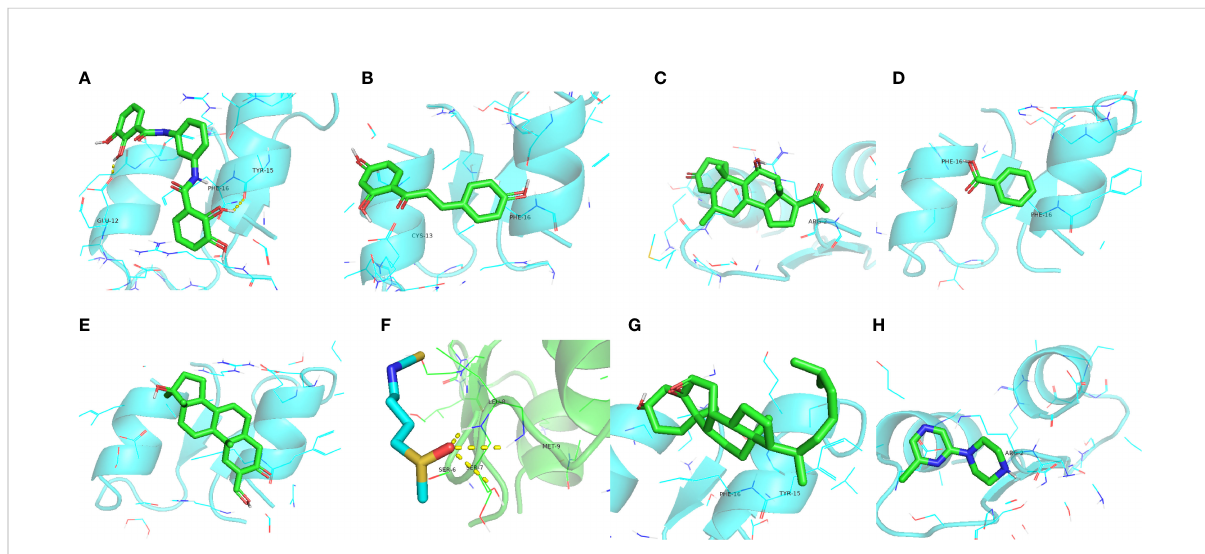
FIGURE 9 Molecular docking simulations. (A) EDN1 with telomerase inhibitor IX. (B) EDN1 with isoliquiritigenin. (C) EDN1 with medrysone. (D) EDN1 with benzoic acid. (E) EDN1 with oxymetholone. (F) EDN1 with sulforaphane. (G) EDN1 with epoxycholesterol. (H)